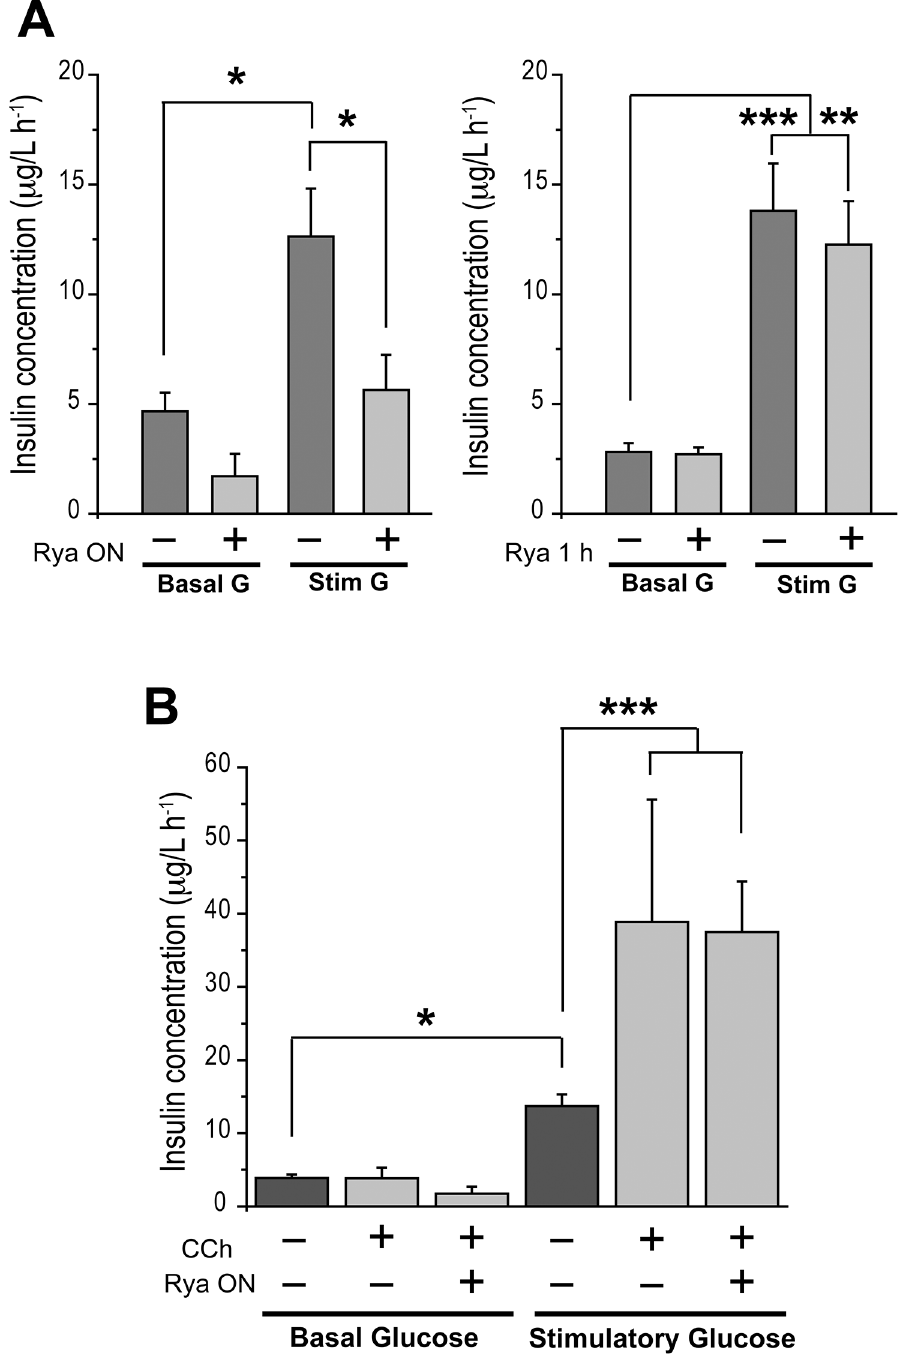
Fig 2. Overnight incubation of pancreatic islets with 200 μ M ryanodine inhibits insulin secretion stimulated by glucose but not by glucose plus carbachol. Insulin secretion was determined in groups of 15 islets after incubation for 1 h at 37°C in basal (2.8 mM) or stimulatory glucose (16.7 mM). (A, left) Rya ON: islets were pre-incubated with 200 μ M ryanodine for 12 h before determination of insulin secretion after 1 h incubation in ryanodine-free solutions. (A, right) Rya 1 h: islets were pre-incubated with 100 μ M ryanodine for 1 h before determination of insulin secretion after 1 h incubation in ryanodine-free solutions; G: glucose. (B) CCh: 30 μ M carbachol was added during the 1 h incubation period used to measure insulin secretion. All data represent Mean ± SEM; N = 3 experiments (each condition in triplicate). Statistical significance was determined with one-way ANOVA followed by Tukey multiple comparison test. * : p < 0.05; ** : p < 0.01; *** p < 0.001. doi:10.1371/journal.pone.0129238.g002 PLOS ONE | DOI:10.1371/journal.pone.0129238 June 5,